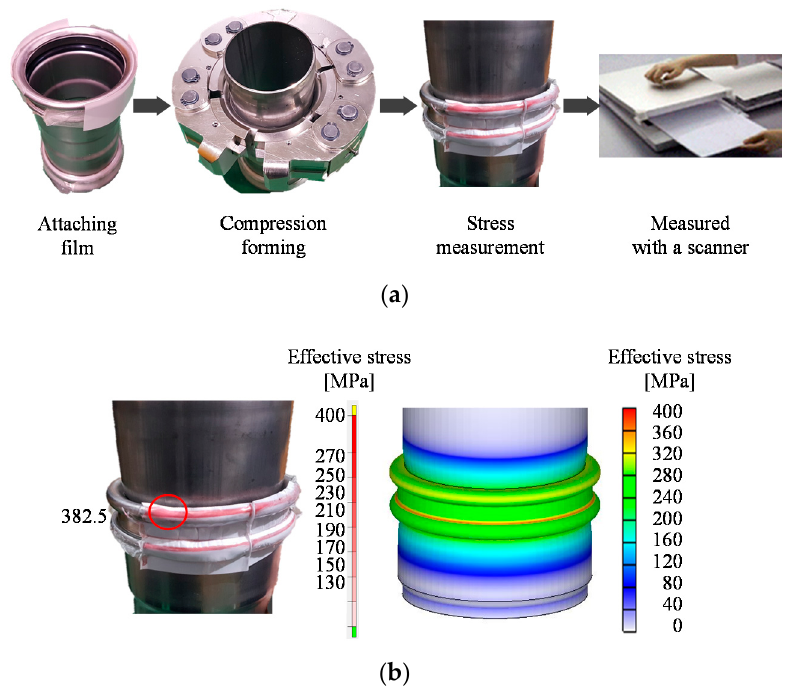
Figure 16. ( a ) Verification with pressure film; ( b ) comparison of effective stress between experi- ment and FE analysis. and FE